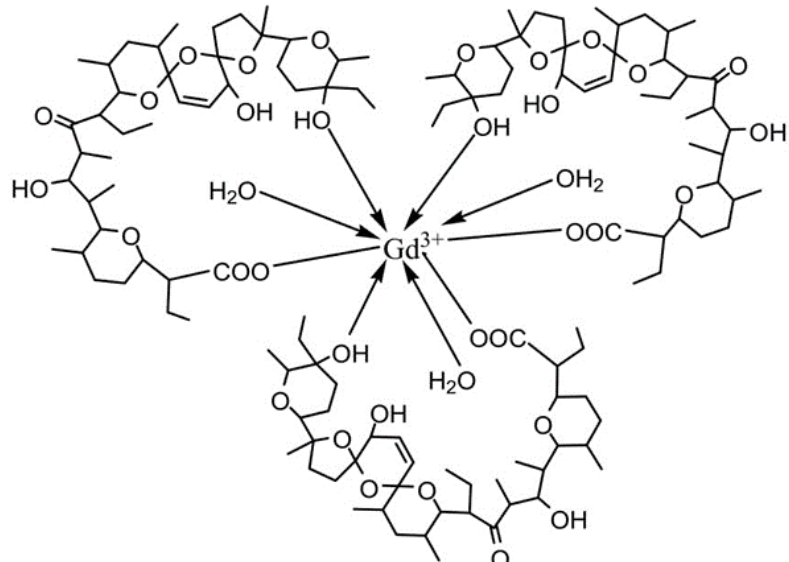
Figure 9. Proposed chemical structure of [Gd(C 42 H 69 O 11 ) 3 (H 2 O) 3 ].